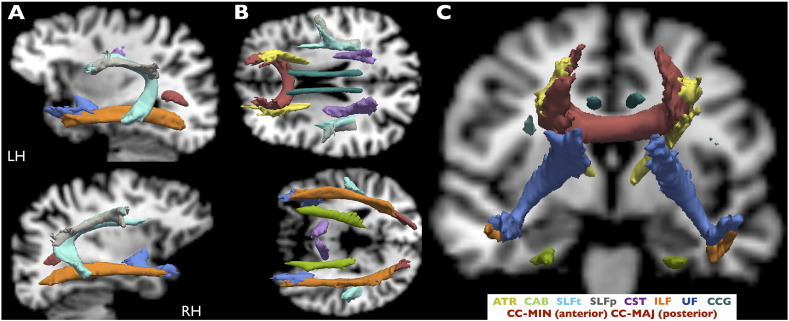
All reconstructed TRACULA tracts.Estimated probability tracts from TRACULA are overlaid on a healthy subject's T1-w scan (native space) and shown in sagittal (A), axial (B) and coronal (C) views. TRACULA tracts included in further analysis were CAB, SLFt, ILF and UF. All images are presented in radiological convention.RH = Right Hemisphere; LH = Left Hemisphere; CC-MIN: corpus callosum – forceps minor; CC-MAJ: corpus callosum – forceps major; ATR: anterior thalamic radiations; UF: uncinate fasciculus; ILF: inferior longitudinal fasciculus; CAB: cingulum–angular bundle; SLFt: superior longitudinal fasciculus - temporal segment; SLFp: superior longitudinal fasciculus - parietal segment; CST: corticospinal tract; CCG: cingulum–cingulate gyrus bundle. All tracts are shown in isosurface at 20% of maximum probability.